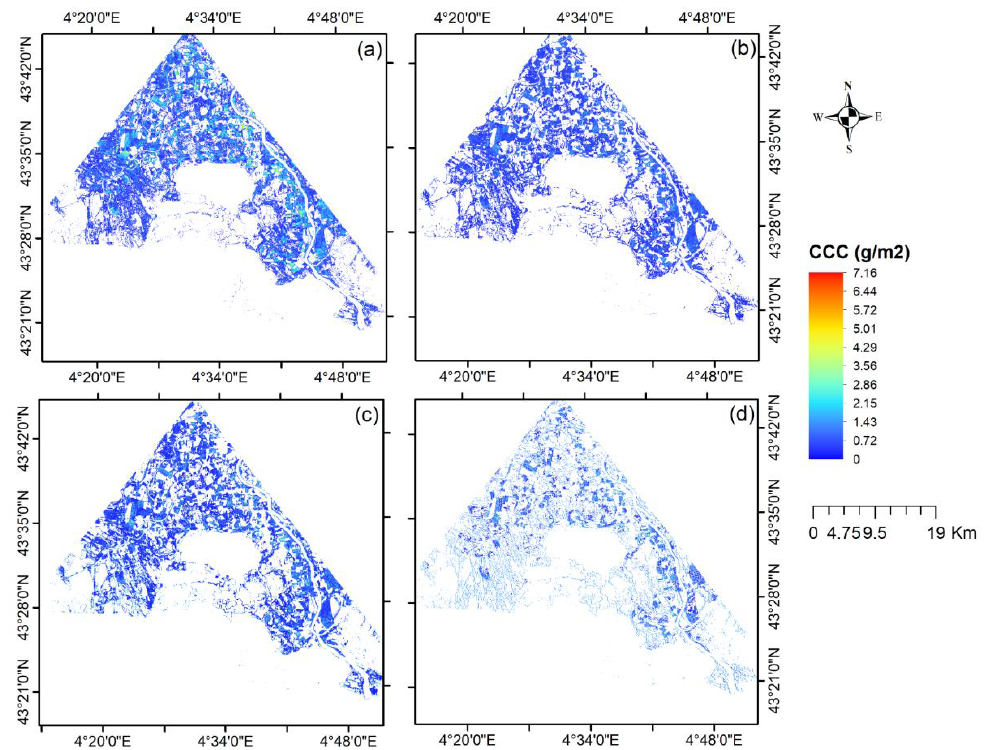
Figure 4. CCC products retrieved from Sentinel-2 image of 19 July 2018, by running the SNAP toolbox